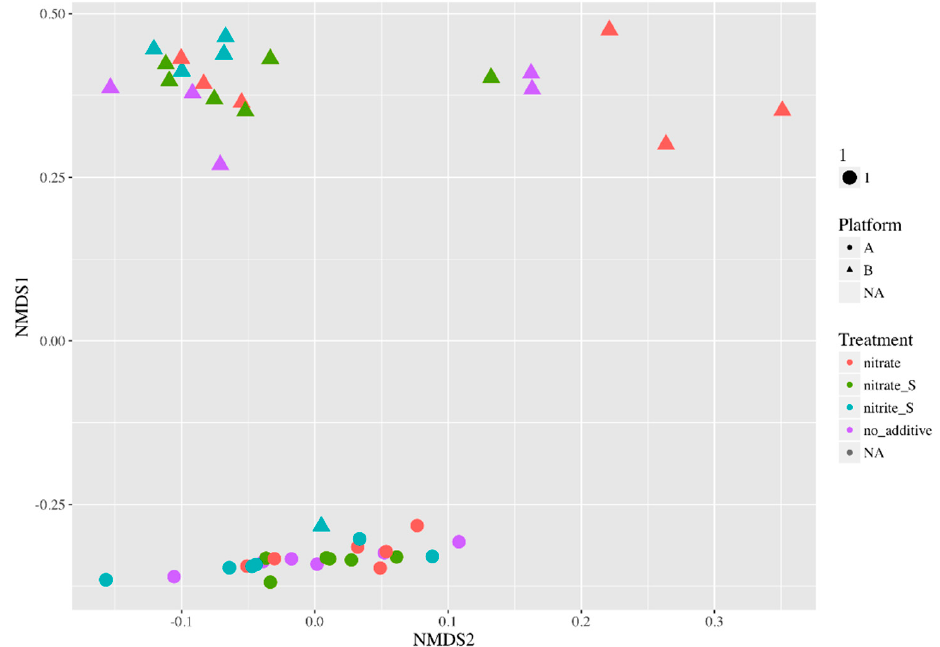
Figure 8. Non-metric multidimensional scaling (NMDS) plot describing the Bray–Curtis dissimilarity between 16S rRNA gene sequencing DNA libraries of Platforms A (circles) and B (triangles), and various treatments (differentiated by color). Each data point represents the microbial community present in one microcosm after the 156-day incubation.